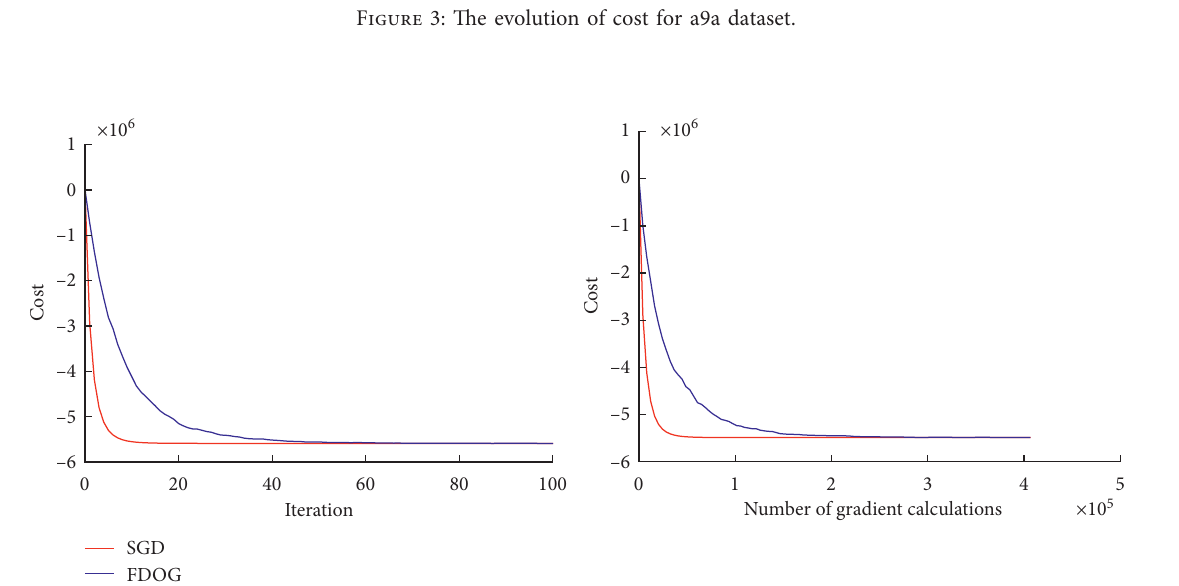
Figure 3: The evolution of cost for a9a dataset.